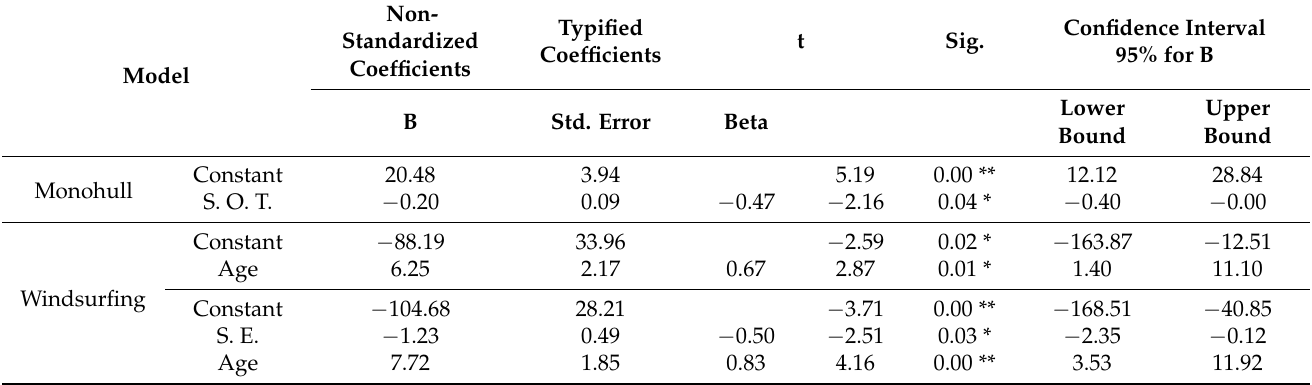
Table 2. Coefficients of the linear regression models in Monohull and Windsurfing